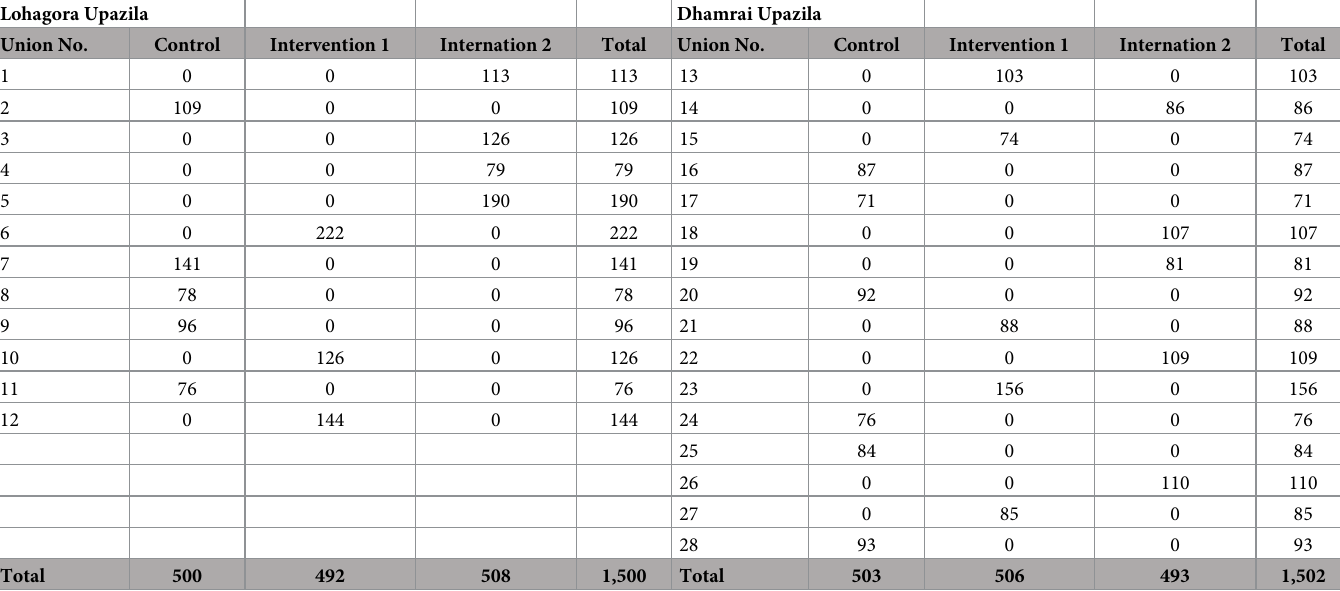
Table 1. Study settings and